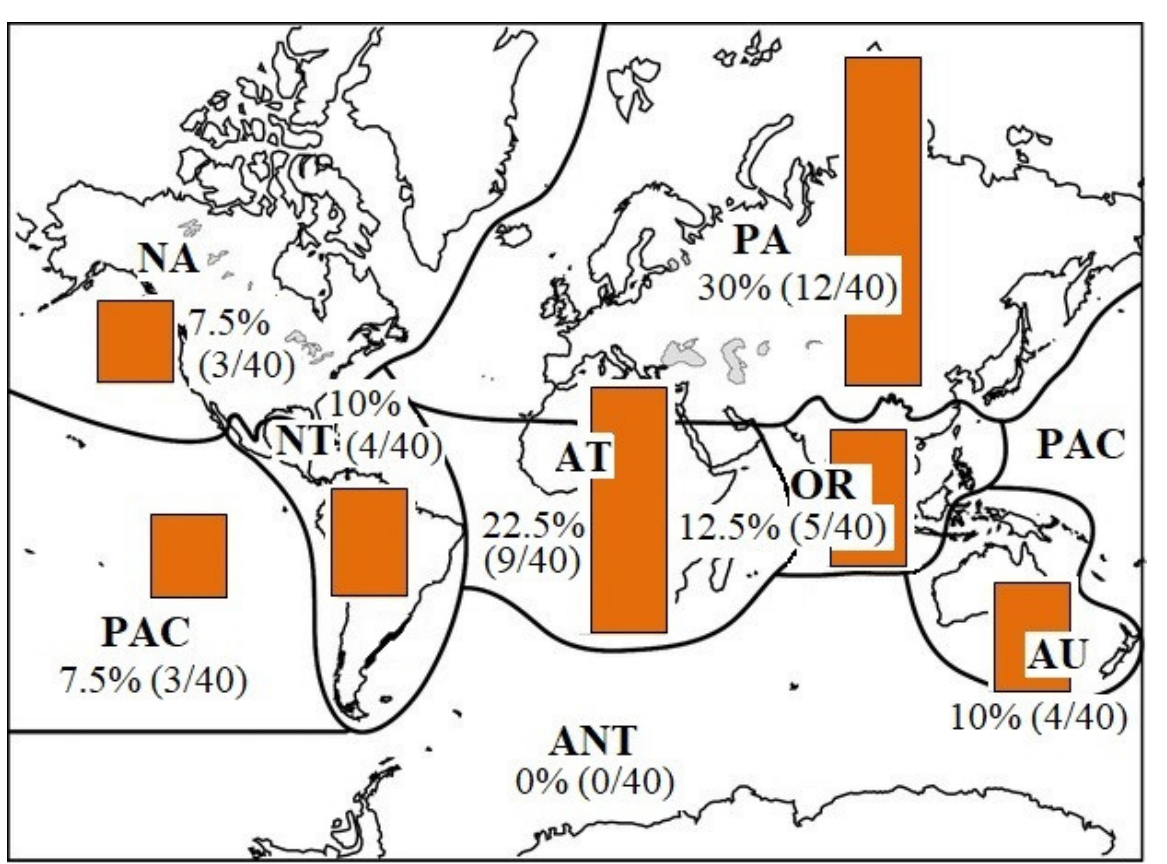
rostral variability in shape and dentition has been observed in many hippolytid shrimps (Table 1). For example, H. garciarasoi , H. leptocerus, and H. varians are the species with obvious types in rostral shape and dorso-ventral dentition, while H. inermis , H. niezabitowskii and H. prideauxiana are variable only in the meristic characters and the position of the rostral dentition (Table 1). Usually, the observed variability is continuous with intermediate forms or morphotypes, which are dispersed along the species’ distributional ranges. The only species of the genus with the most characteristic sharp dimorphic rostral system is H. sapphica .